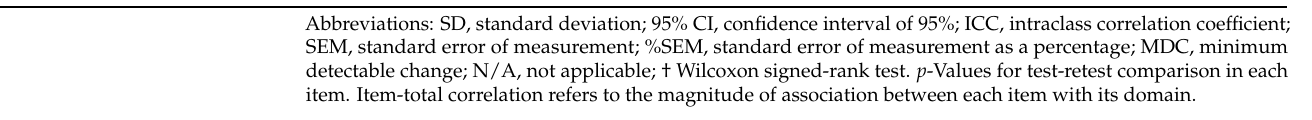
Table 4. Reliability, test–retest and systematic differences of motivation and confidence questions from CAPL-2 battery assessment.